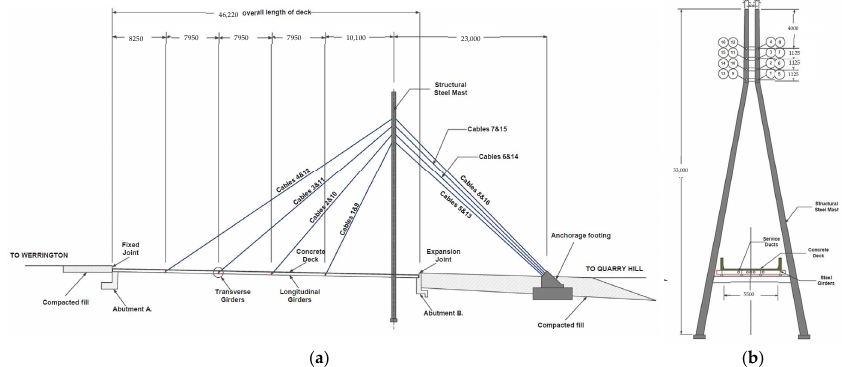
Sensors 2023 , 23 , x FOR PEER REVIEW Figure 4. Schematic view of the cable-stayed bridge [1]. ( a ) Elevation view of the bridge; ( b ) bridge mast.